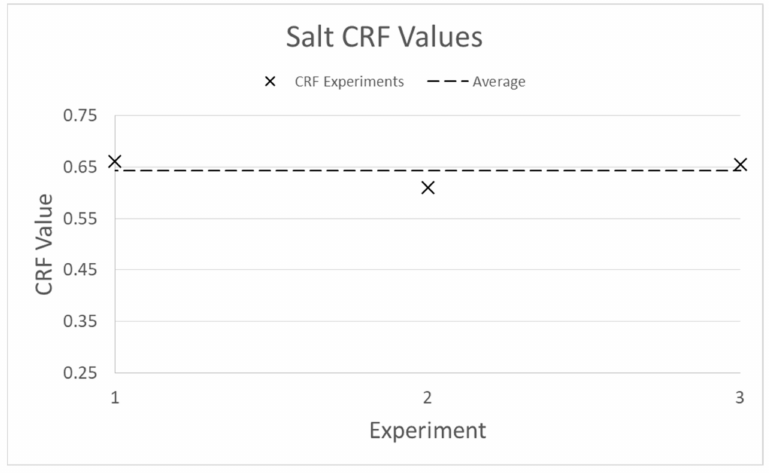
Figure 13. Repeatability tests with the same experimental set up for the reference material salt.